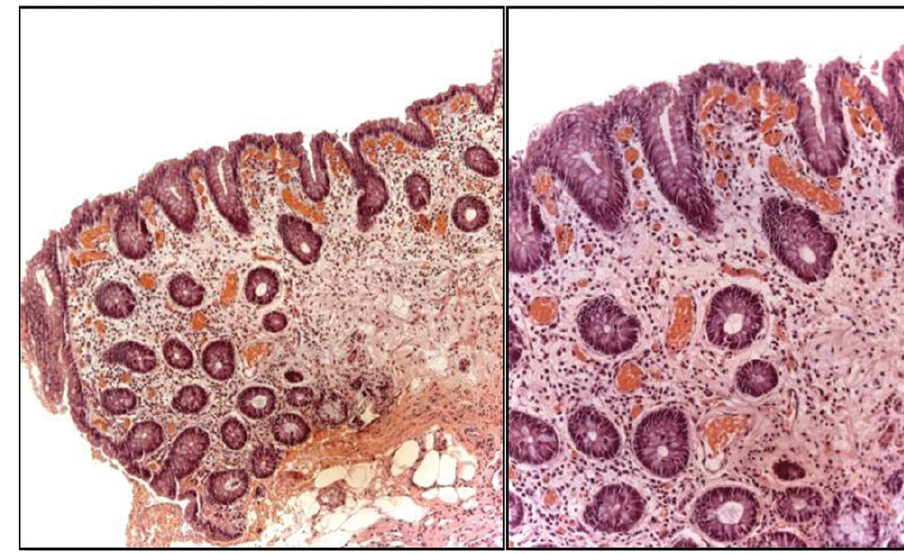
Figure 3 - Colonic Metaplasia. Only crypts are observed. Absence of Paneth cells or